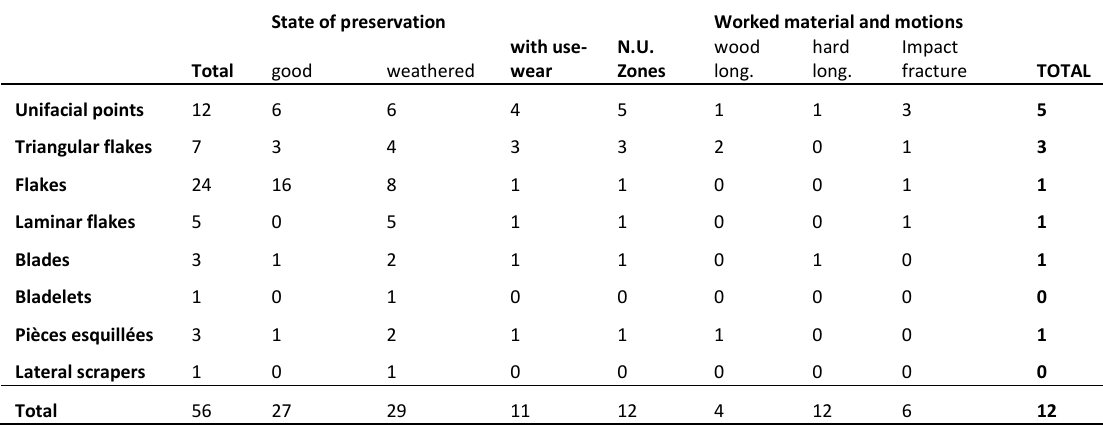
Table 4 . Synthesis of the analyzed material from the stratigraphic unit Lynn at Diepkloof Rock Shelter and results of the functional analysis (the N.U. Zones correspond to the number of used zones; long. = longitudinal). State of preservation Worked material and